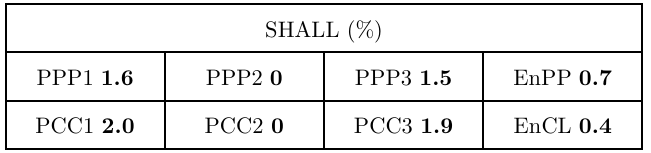
Shall in original English and translated Polish